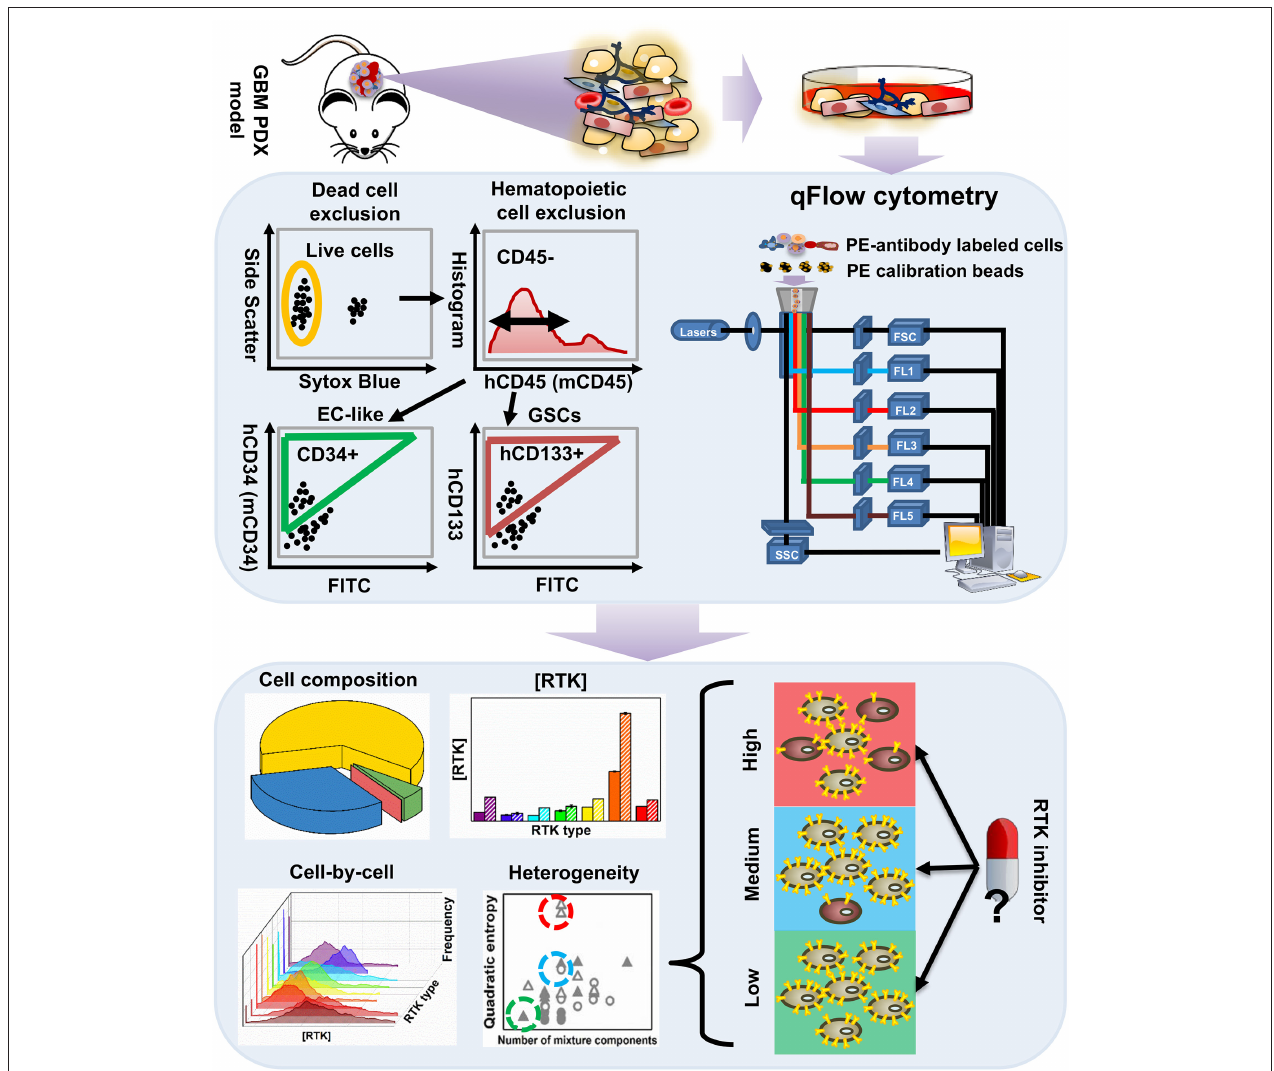
FIGURE 1 | An overview of the workflow for characterizing tumor heterogeneity in GBM39 PDX samples. The GBM39 PDX is established with tumor tissue from patients at Mayo Clinic, Rochester, MN. Following dissociation, multi-channel flow cytometer is used to characterize PDX cells. Briefly, dead cells are excluded using a live/dead cell stain, and hematopoietic cells are excluded using the CD45 antigen, then the endothelial marker CD34 and CD133 can be used to identify EC-like cells and GSCs respectively from the CD45 − pool. Percentage of GSCs, EC-like cells and other PDX cells within all live cells can be exported from the flow cytometer. Cells are also stained with phycoerythrin (PE)-conjugated antibodies targeting one of the 9 plasma membrane RTKs: established GBM biomarkers, EGFR and IGFR, and those within the angiogenic signaling networks, VEGFRs, PDGFRs, NRP1, and Tie2. qFlow cytometry is performed as described previously, and ensemble averaged plasma membrane RTK concentrations and cell-by-cell RTK distributions can be obtained (Imoukhuede and Popel, 2011; Chen et al., 2015, 2017). We use two parameters to quantify RTK heterogeneity across EC-like and non EC-like cells: number of mixture components and Quadratic entropy of the cell-by-cell RTK distribution. Bayesian Information Criterion (BIC)-guided Gaussian mixture modeling is used to select the best number of mixture components existed in a larger cell population based on their RTK concentration. Alternatively, Quadratic entropy sums the weighted differences of the means between two bins from 500 equally distributed bins from each cell-by-cell distribution. We envision that characterizing RTK heterogeneity may help understand why RTK inhibitors have not been efficient in treating